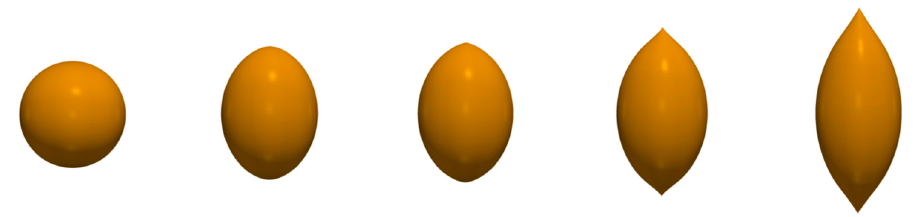
Figure 9. Shape evolution of a MAE sphere with the magnetic susceptibility χ = 0.2 under increasing magnetic field; the nondimensional magnetic field strengths are (from left to right): H 0 = 0; 5.7; 6.12; 7.42 and 9.55. H 0 is defined as H 0 = H 0 /√𝐺, where 𝐺 is the MAE’s shear modulus [116]. Note that the normalization is performed in the cgs system of units.